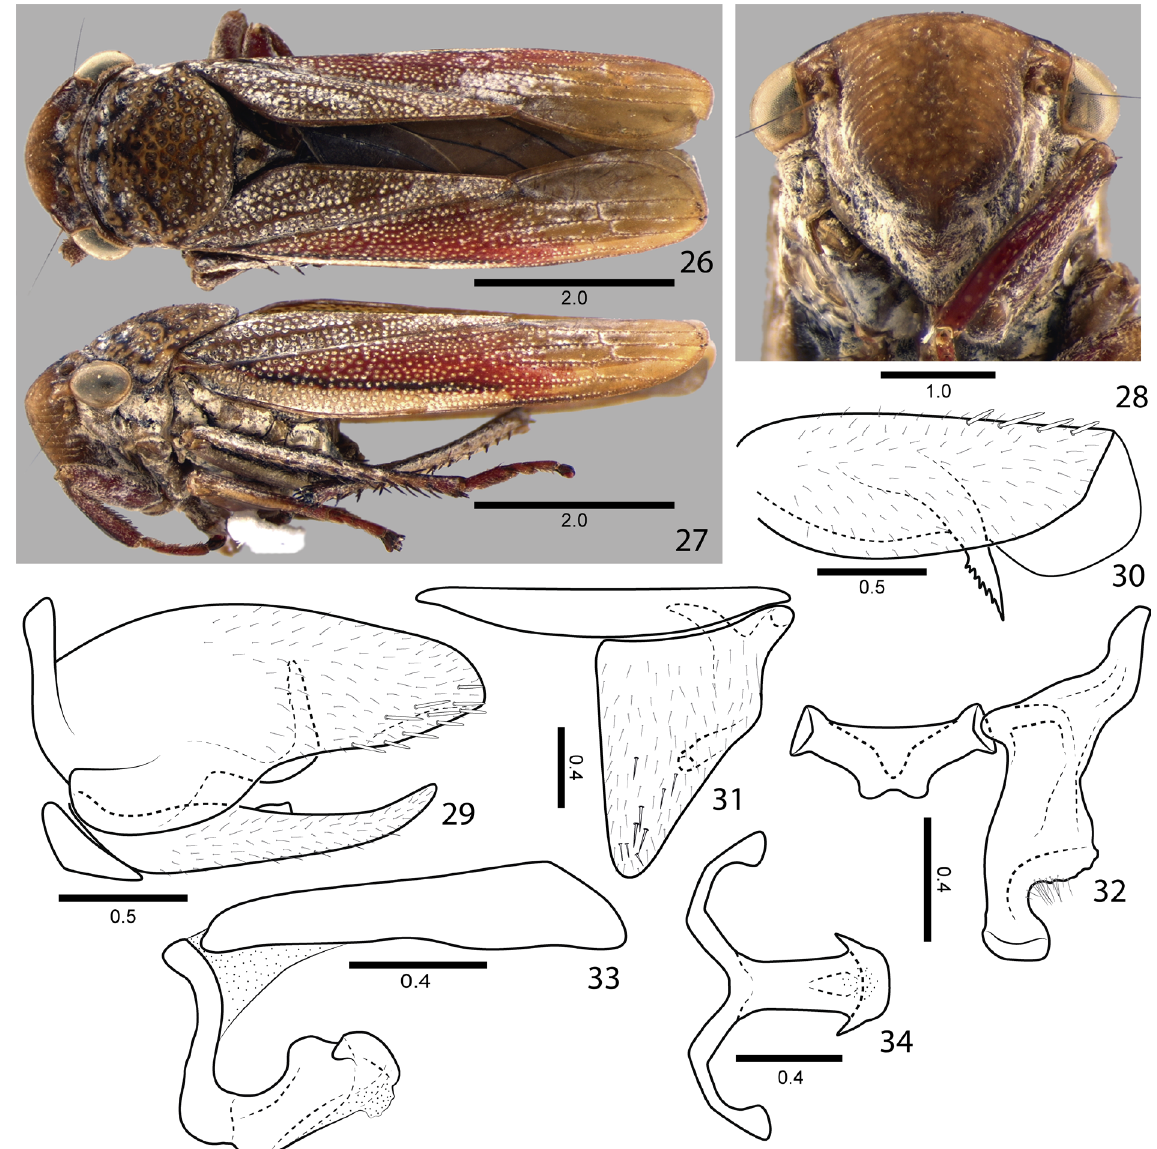
Figs 26–34. Tretogonia dentalis Emmrich, 1988, ♂ (DZUP 215388). 26 . Body, dorsal view. 27 . Body, lateral view. 28 . Face, frontal view. 29 . Valve, pygofer and subgenital plate, lateral view. 30 . Pygofer, dorsal view. 31 . Valve and subgenital plate, ventral view. 32 . Connective and style, dorsal view. 33 . Aedeagus and basal segment of anal tube, lateral view. 34 . Aedeagus, ventral view. Scales in